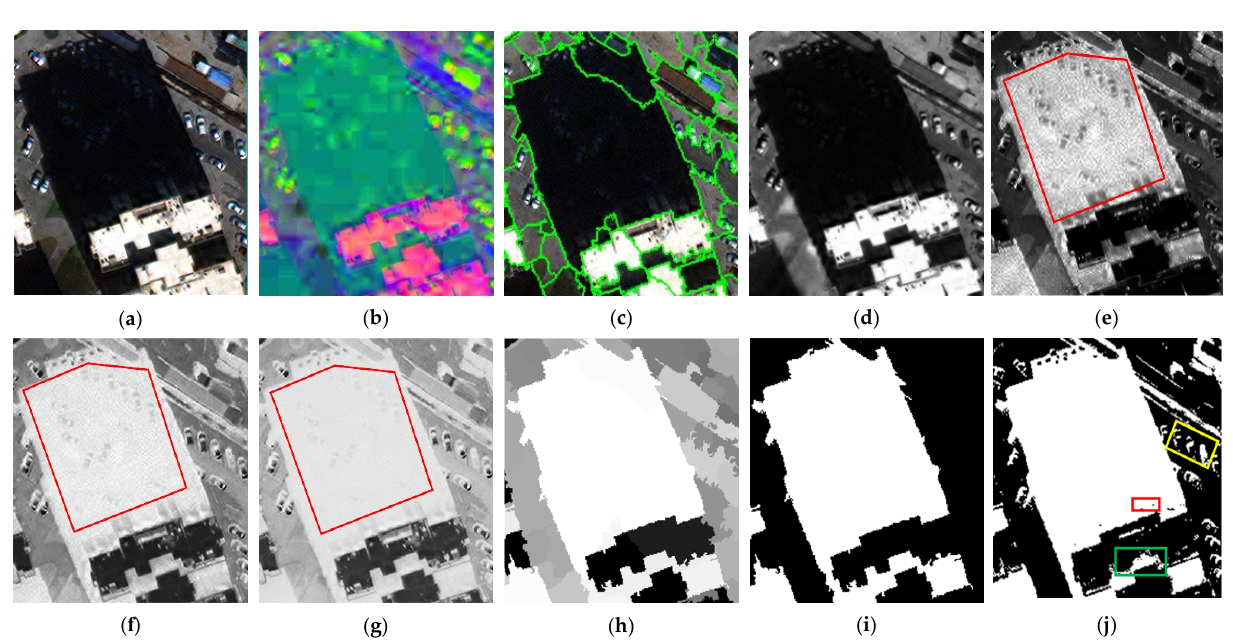
Figure 3. Shadow extraction process, where ( a ) is the original image displayed by RGB bands; ( b ) is YCbCr model; ( c ) is the boundary of the mean-shift segmentation result; ( d ) represents the NIR band; ( e ) is the T YCbCr ; ( f ) is the result of SI; ( g ) is the result of ISI; ( h ) is the reconstructed ISI by using segmentation results; ( i ) is the threshold segmentation result of ( h ); and ( j ) is the result of threshold segmentation of ( g ).